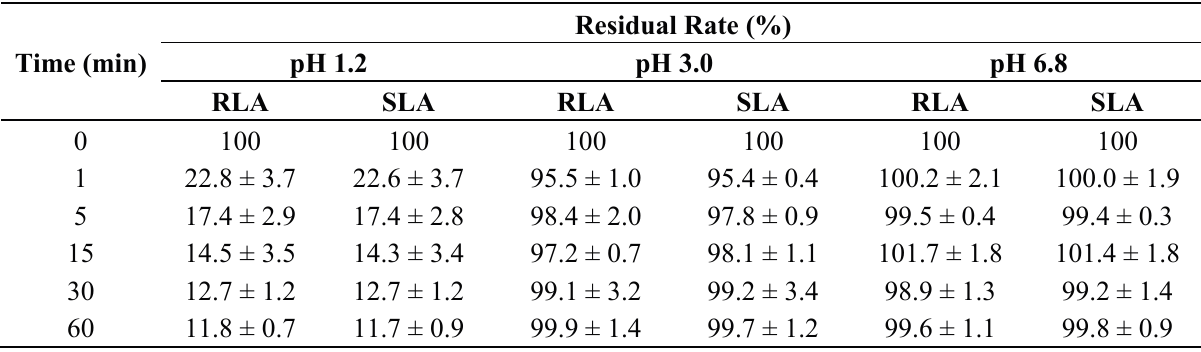
Table 1. The stability of α -lipoic acid in various pH solutions.